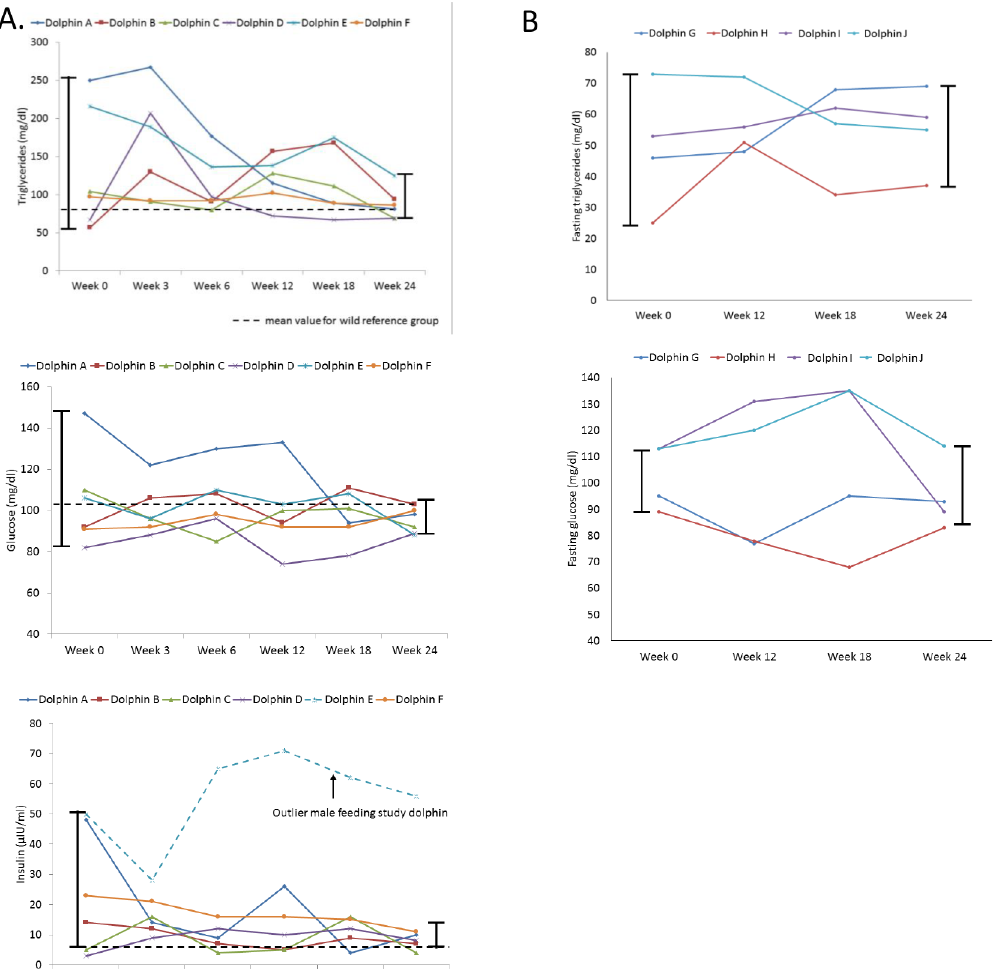
Fig 3. Blood-based indicators of metabolic syndrome and measures of spread in bottlenose dolphins during a 24-week feeding study, including A) triglycerides, glucose, and insulin (for insulin, decrease in spread is only present when excluding one outlier dolphin), and B) triglycerides and glucose in reference dolphins. The dashed line indicates the mean value for the Sarasota Bay reference group.